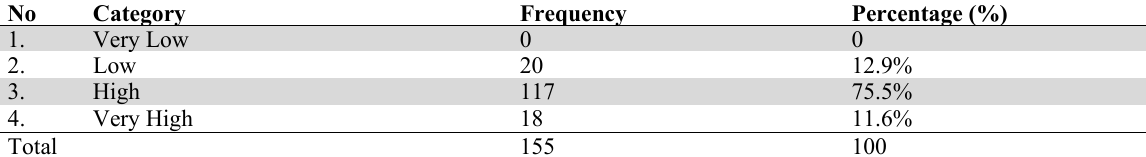
Advertising Exposure of Lazada Indonesia on